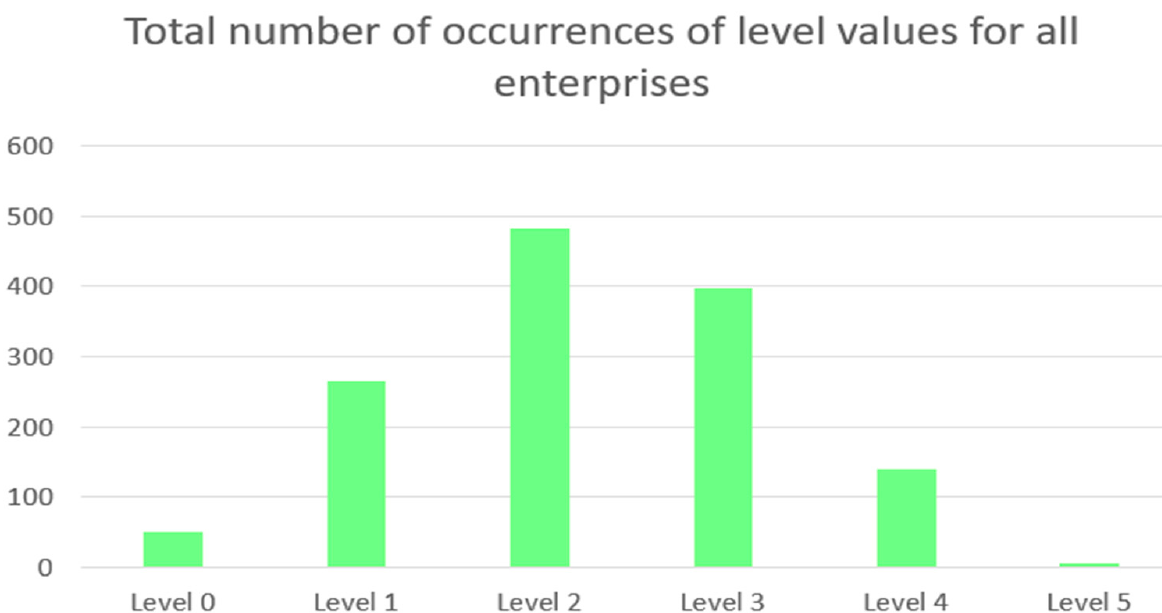
Figure 4. Total number of occurrences of level values for all enterprises.